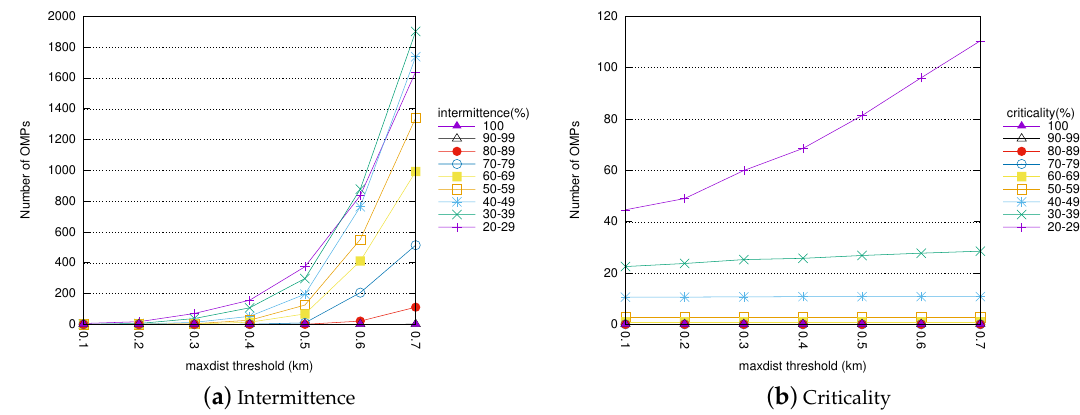
Figure 9. Barcelona. Impact of the maximum distance threshold on the characteristics of the mined OMPs. full-th = 3. time slot size = 1